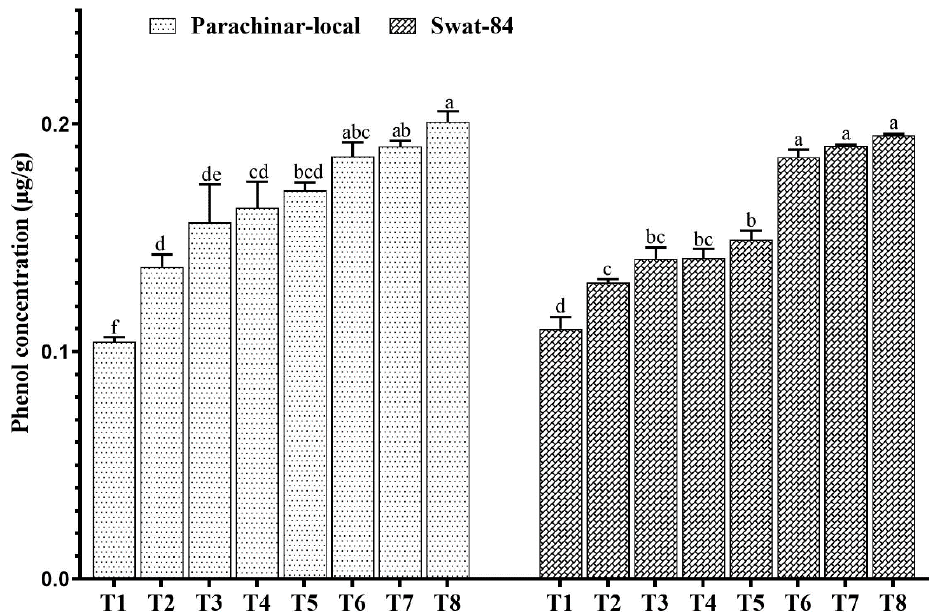
Figure 4. Changes in phenol concentration under salt stress and exogenous JA application. Different letters for each column for each variety show significantly different values at p < 0.05 according to Duncan’s method. T1 (Control), T2 (Control + JA), T3 (40 mM), T4 (40 mM + JA), T5 (80 mM), T6 (80 mM + JA), T7 (120 mM), T8 (120 mM + JA).